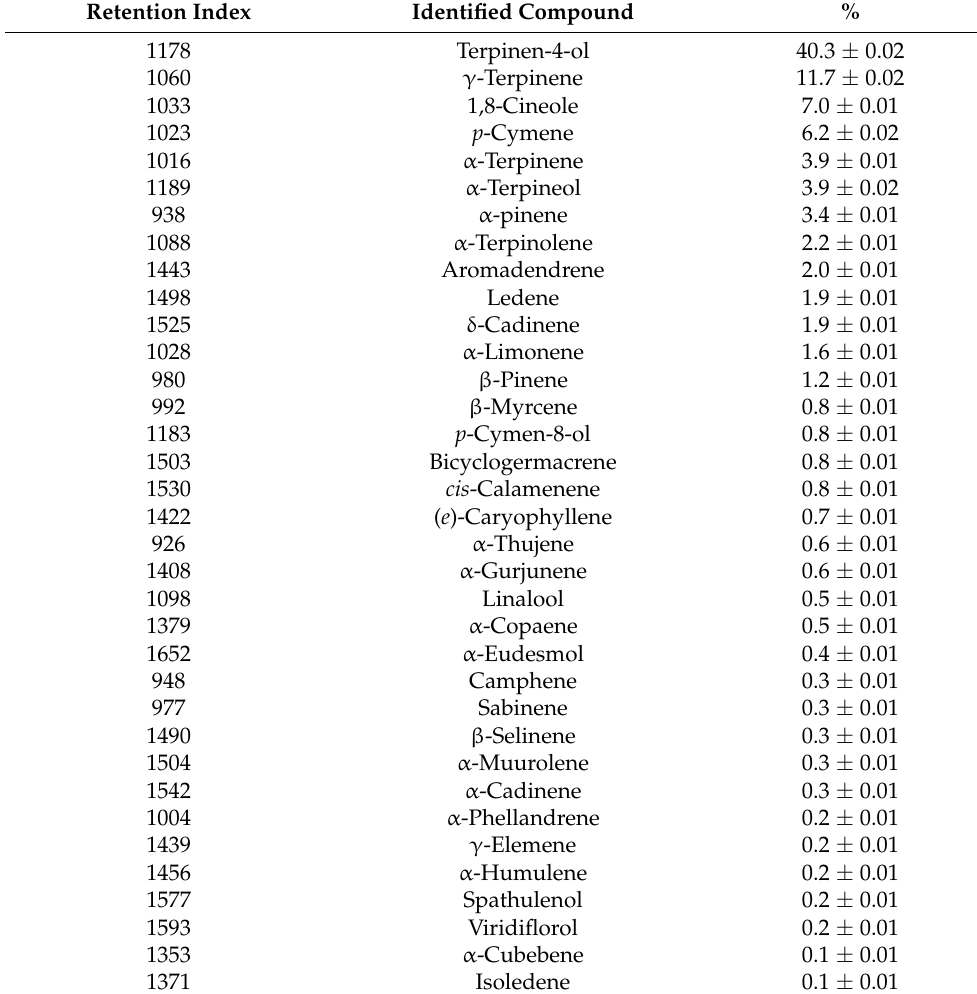
Table 1. Chemical composition of